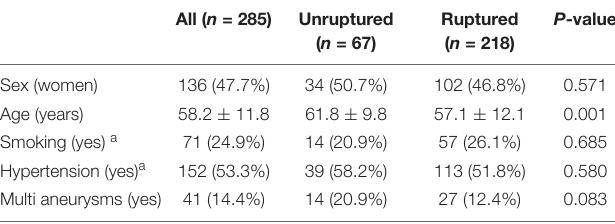
TABLE 1 | Baseline characteristics.